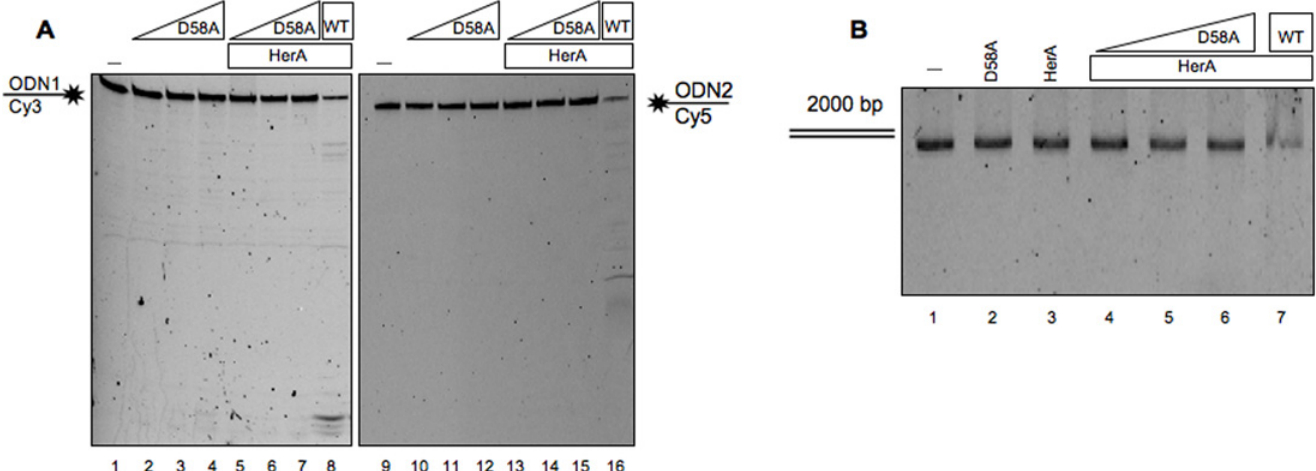
Fig 2. NurA D58A mutant activity assays. (A) Increasing amounts (2.5, 5 and 10 pmoles) of NurA D58A were analyzed for their nuclease activity, on single-stranded DNA, separately (lanes 2 – 4 and 10 – 12) or in presence of 12 pmoles of HerA (lanes 5 – 7 and 13 – 15) on two different substrates ODN1 and ODN2. Lanes 1 and 9 refer to controls in which the only substrate has been loaded, while lanes 8 and 16 refer to positive controls in which 12 pmoles of NurAwt were incubated in presence of 12 pmoles of HerA. (B) Increasing amounts (2, 6 and 10 pmoles) of NurA D58A were analyzed for their nuclease activity, on linear double-stranded DNA, in presence of 12 pmoles of HerA (lanes 4 – 6); lane 1 refers to control in which the only substrate has been loaded, lane 2 refers to NurA D58A alone (10 pmoles) and lane 3 refers to HerA alone (12 pmoles).